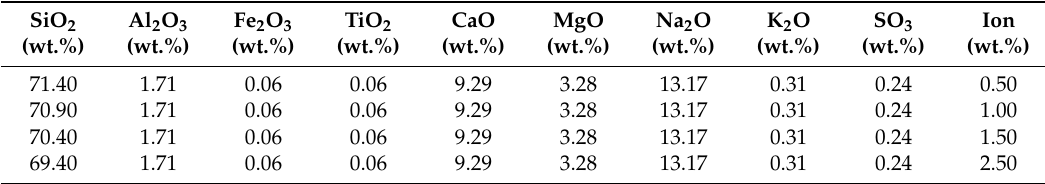
Table 2. Compositions of antibacterial glasses.